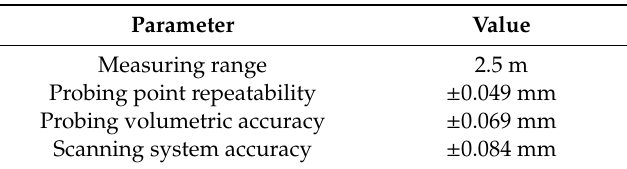
Figure 4. ACMM Hexagon Metrology Absolute Arm 7325SI employed for the ground truth. Image courtesy of Hexagon Manufacturing Intelligence division. Table 3. Technical specifications of metrological 7-axis arm contact measurement, hexagon absolute arm